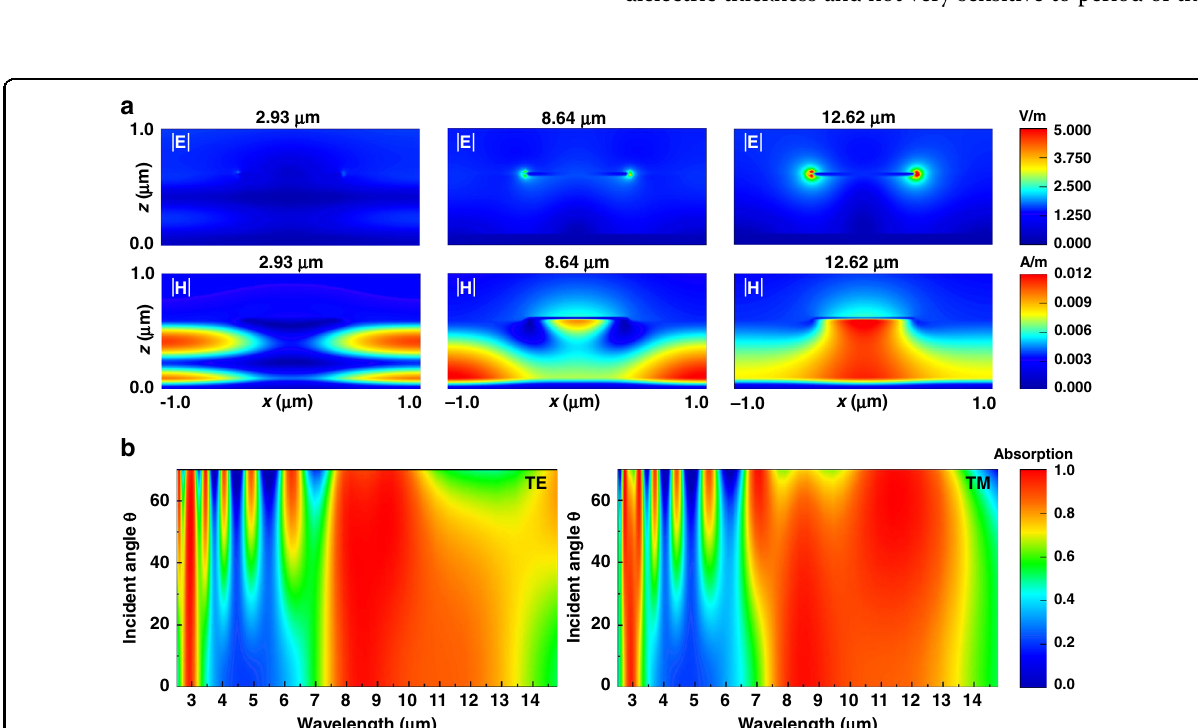
Fig. 2 Analyses of electromagnetic fi eld distributions and absorption spectra for different incident angles. a Electromagnetic fi eld distributions at the three resonant wavelengths along the MIR and LWIR range: 2.93 μ m, 8.64 μ m and 12.62 μ m. b TE-mode (x-polarised) and TM-mode (y-polarised) absorption spectra for incident angles from 0 to